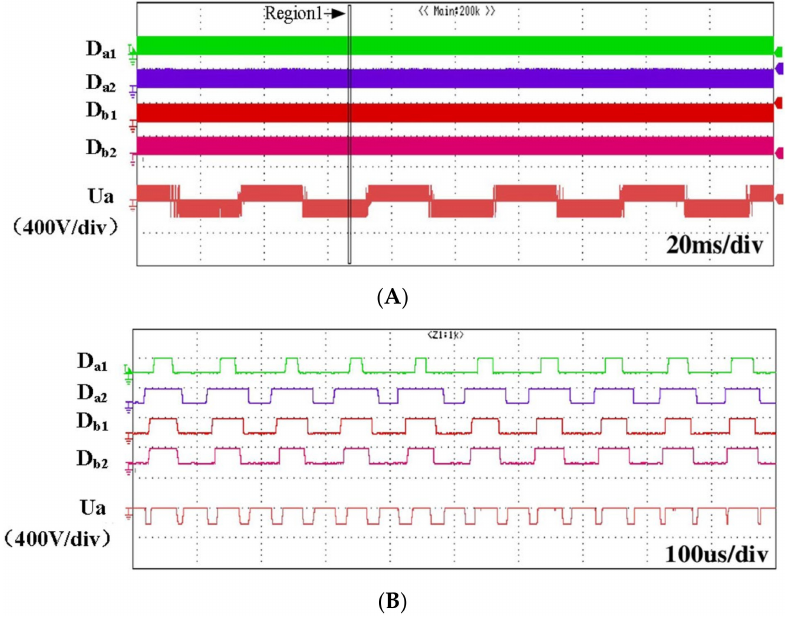
Figure 14. Experimental test of the proposed method. ( A ) The modulation sequence based on decoupling modulation; ( B ) Enlarge view of